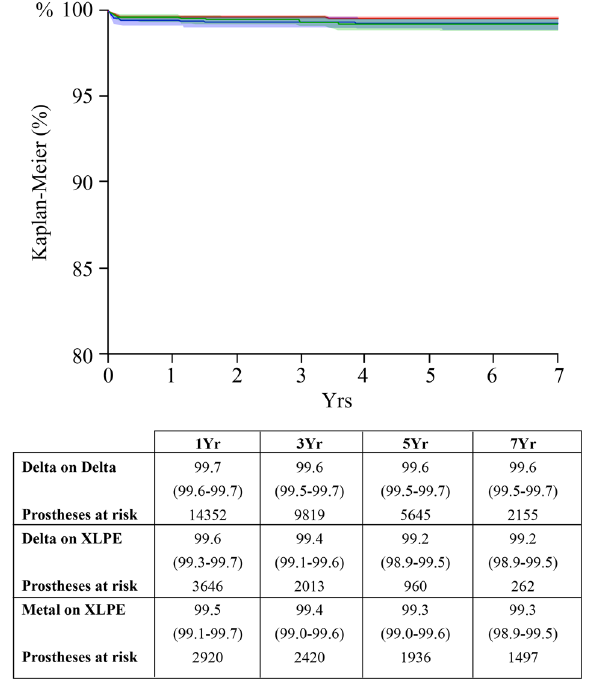
Fig. 2 Recent couplings did not show signi fi cant differences in terms of revision due to dislocation (Kaplan – Meier curves, endpoint: revi- sions due to recurrent dislocations and primary instability). Delta-on- Delta: red line. Delta-on-XLPE: green line. Metal-on-XLPE: blue (Fig. 1). The lower rate of dislocations with hard-on-hard